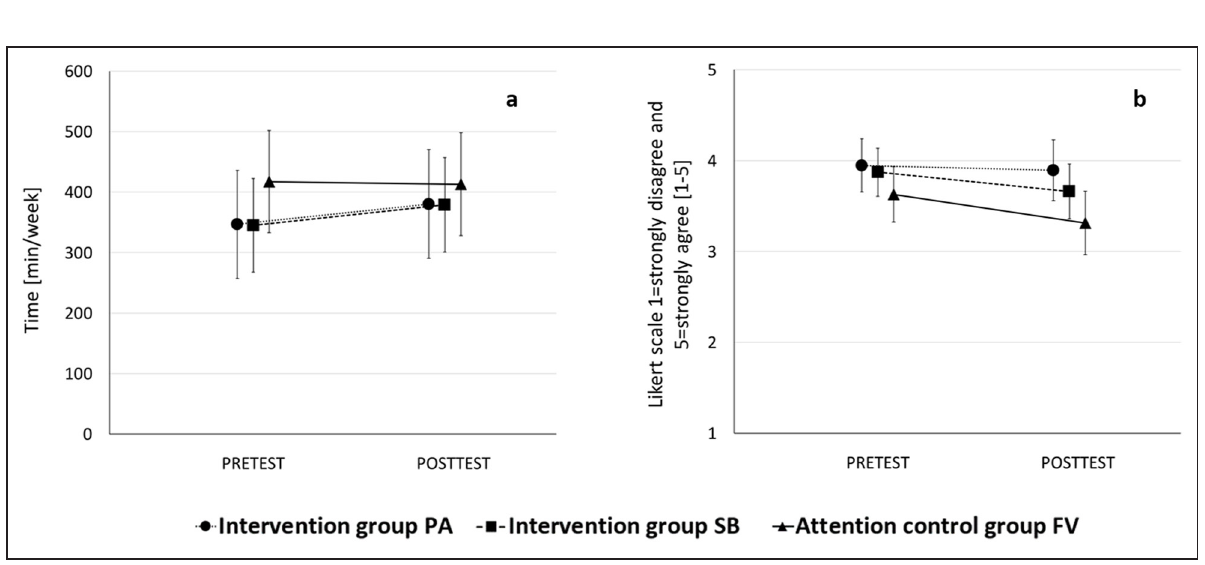
Figure 2 Pre- and post-test means and 95%-Confidence Intervals of the PA variables. a Weekly MVPA time by intervention group. b MVPA Intention. Note that means and CIs are shifted left/right in order to make it more